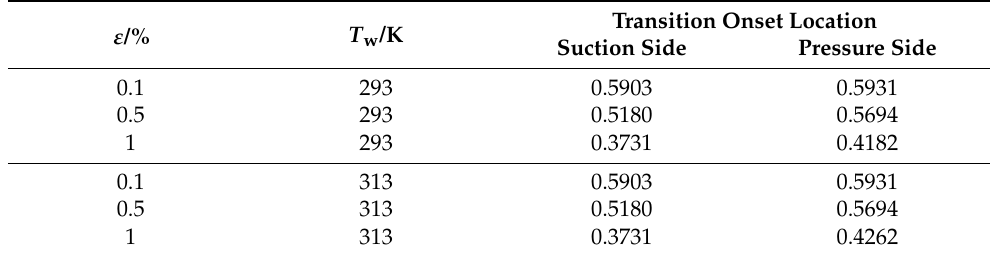
Table A1. Influence of turbulent intensity on transition onset location ( α = 0 ◦ , Ma = 0.4).